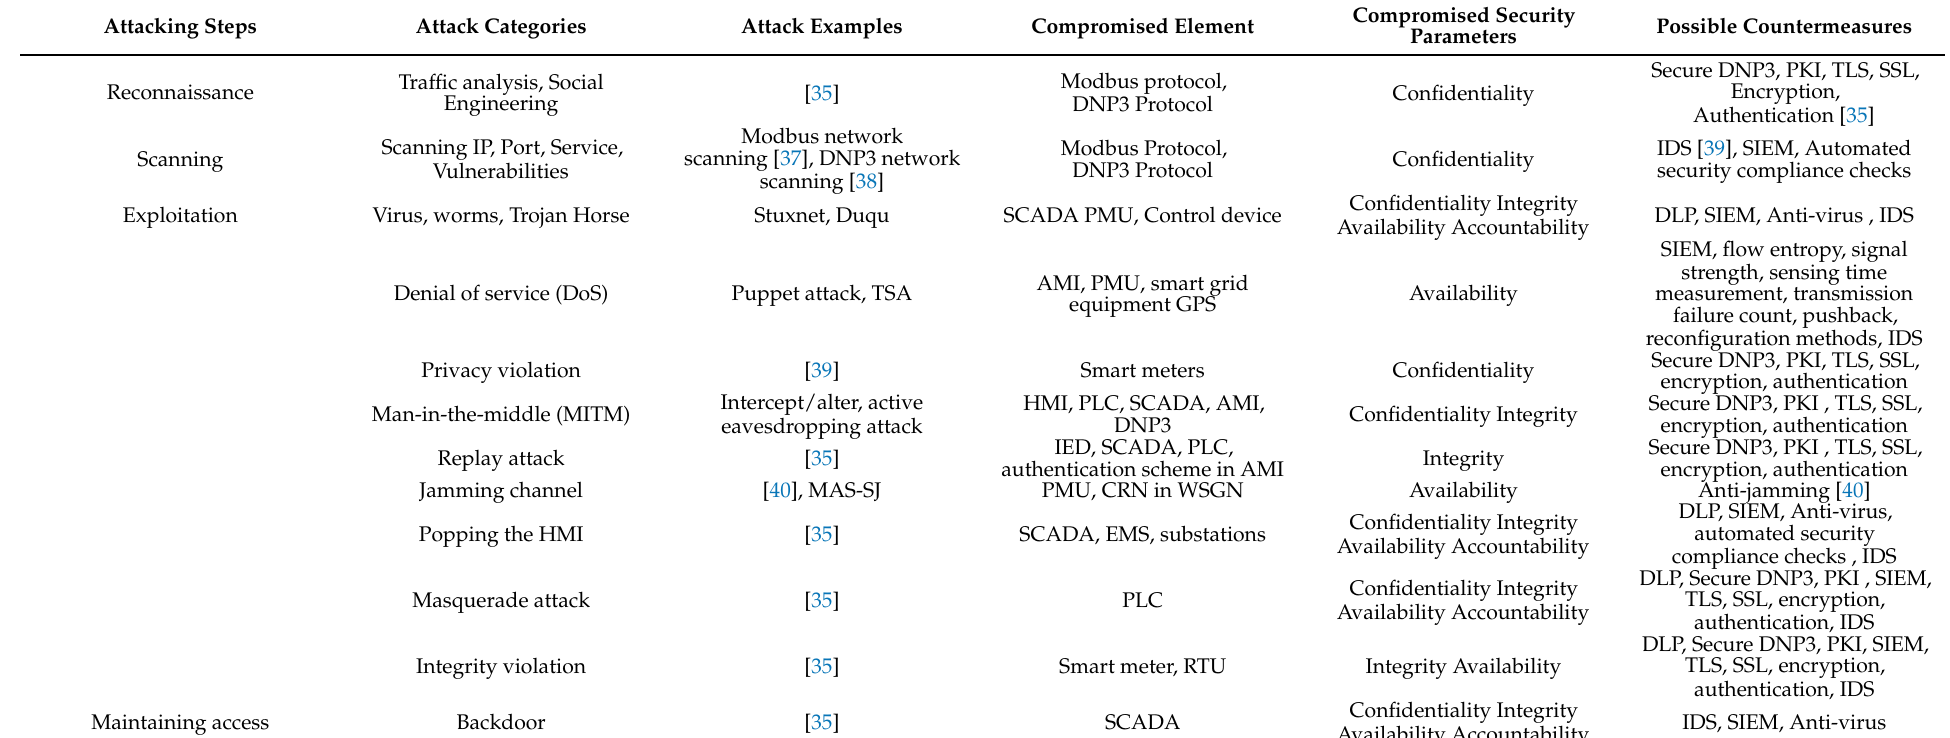
Table 2. Cyber-attacks on microgrid, their impacts, and